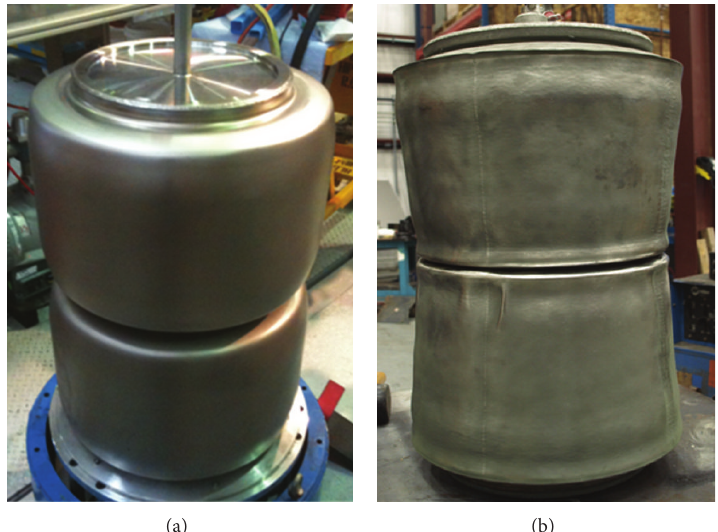
Figure 7: An ANSTO dumbbell design HIP can (100L capacity) containing over 170 kg of Synroc waste form, before HIPing (a) and after HIPing (b), which was produced to demonstrate the scalability of